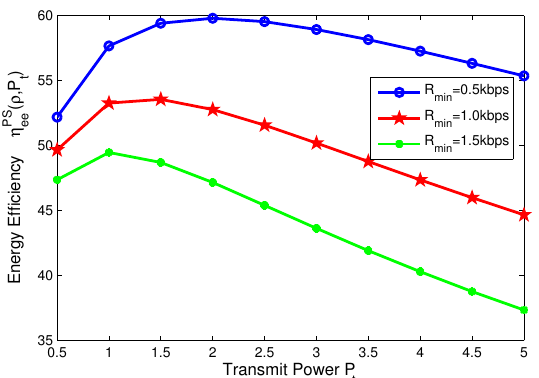
Figure 11. Energy efficiency versus transmit power with different minimum QoS requirements for PS mode.